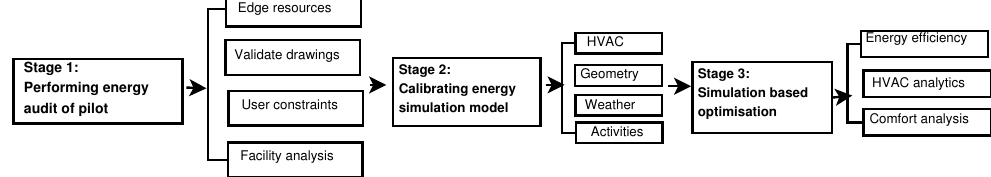
Figure 2. HVAC analysis